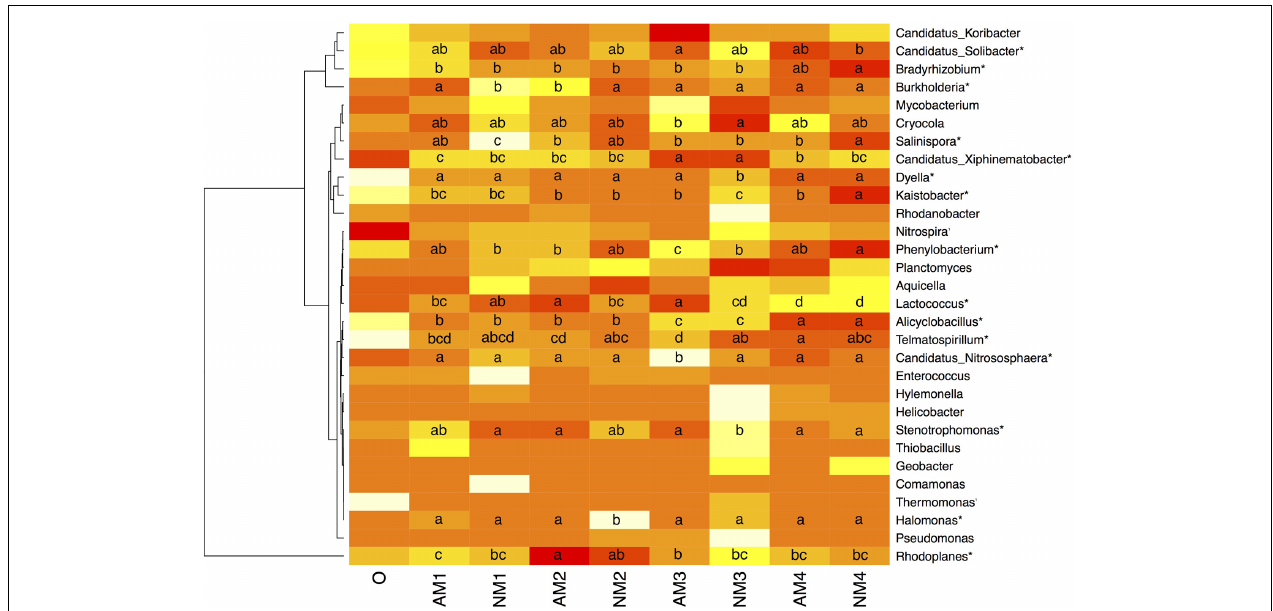
FIGURE 2 | Heatmap and accompanying cluster analysis ( x -axis) of the relative abundance of dominant bacterial genera in all the soil samples with different treatments over different sampling times. Abbreviations: AM represents the treatment inoculated with arbuscular mycorrhizal fungi, NM represents the uninoculated treatment, while O stands for the original soil collected from the forest. Different numbers (1, 2, 3, and 4) represent the different sampling times (T 90 , T 120 , T 150 , and T 180 , respectively). Mean relative abundance is shown for each samples. For each genus, a significant difference either between different sampling times or treatments is noticed by an asterisk ( P < 0.05). Treatments with a letter in common are not different at P < 0.05 according to the Duncan’s multiple range test. Differences were tested among treatment combinations (harvesting times (0 is not included) and arbuscular mycorrhizal inoculation or not) for each genus (per row). The relative abundance for each genus in each soil sample is colored in the shades of yellow (low relative abundance) to red (high relative abundance).